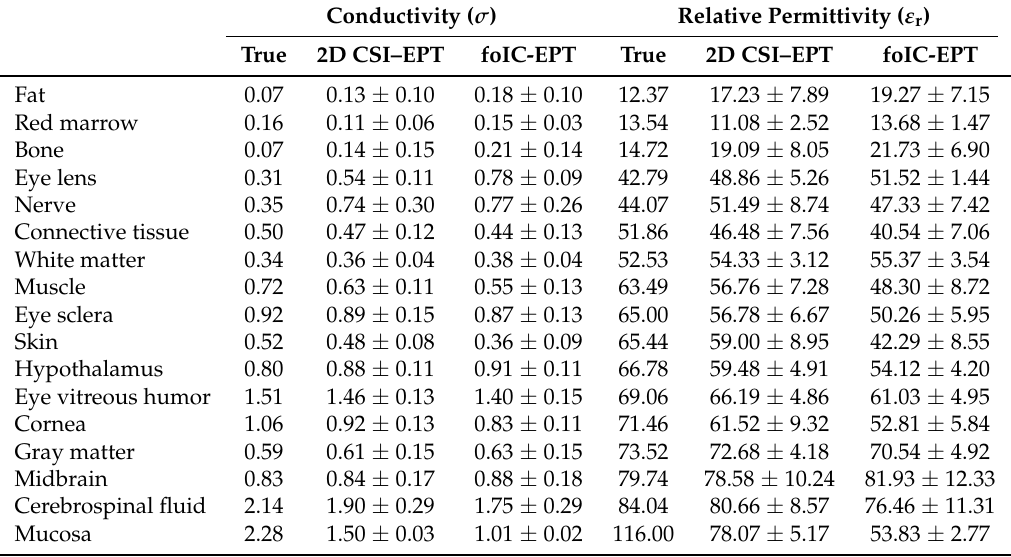
Table 1. Mean and standard deviation of reconstructed electrical properties in different tissue that are apparent in the center slice of the head models using 2D CSI–EPT and foIC-EPT in a two-dimensional setting. Units of σ and ε r are in siemens per meter and permittivity of free space,